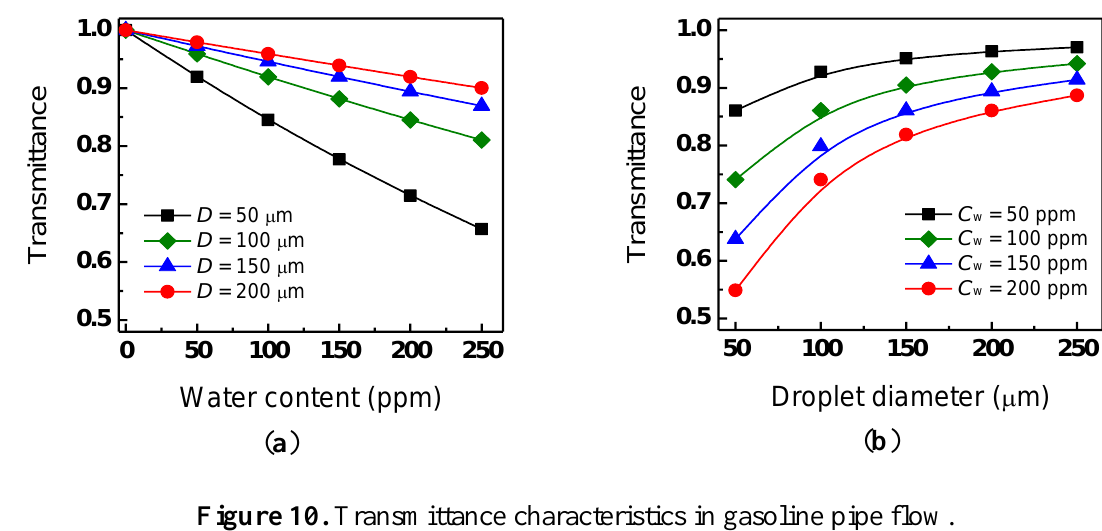
Figure 9. Transmittance characteristics in quiescent gasoline containing monodisperse water droplets: ( a ) transmittance versus water content; ( b ) transmittance versus droplet diameter.